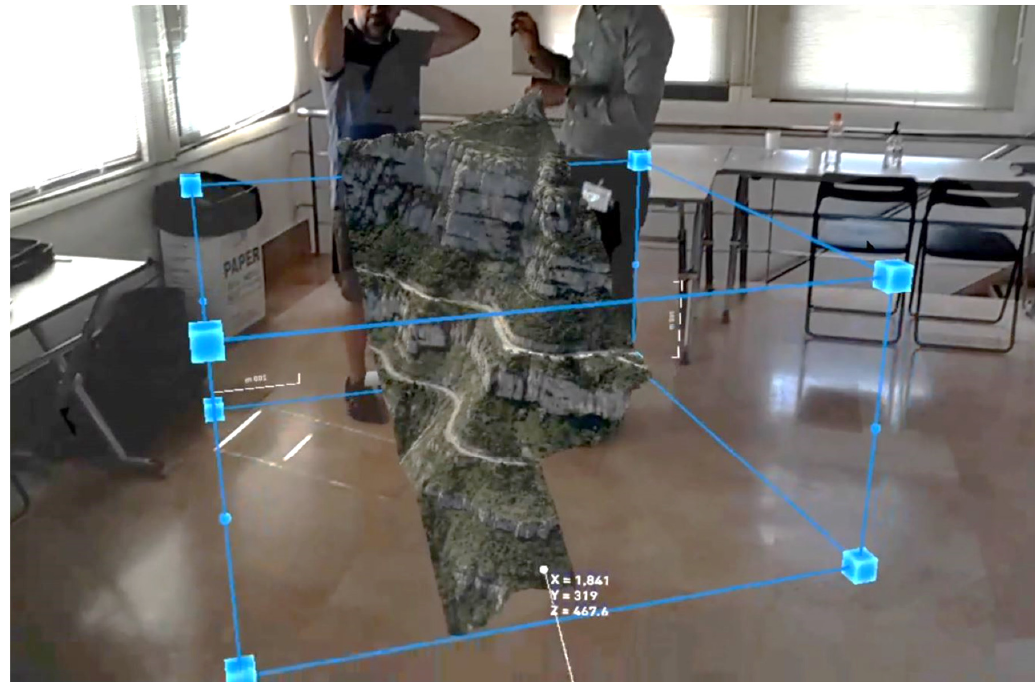
Figure 6. Example of MR as seen in the office through the HoloLens 2 (3D terrain model in Montserrat massif, Degotalls area).